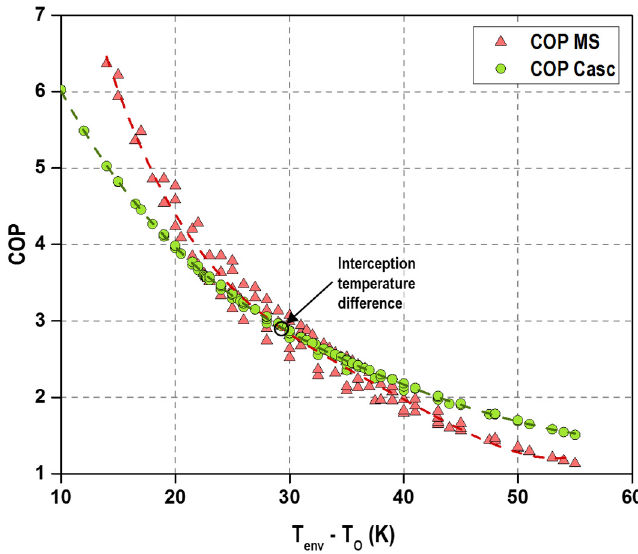
Figure 13. COP dependence on cold and hot sink temperature lift. MS and cascade cycles.